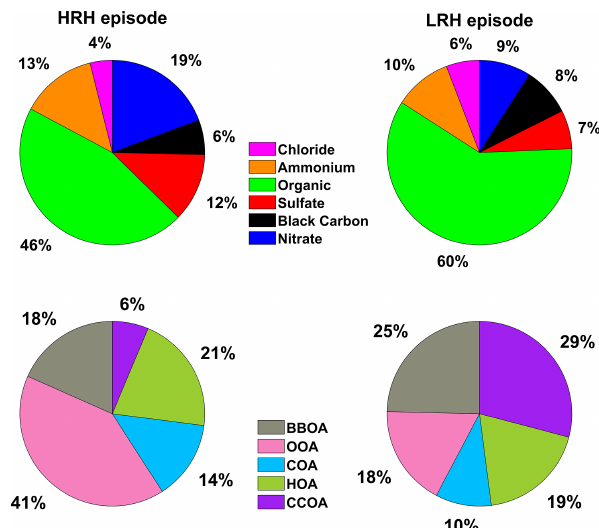
Figure 5. A comparison of the PM 1 chemical composition dur- ing the HRH and LRH episodes. (BBOA: biomass-burning organic aerosols, OOA: oxygenated organic aerosols, COA: cooking or- ganic aerosols, HOA: hydrocarbon organic aerosols, CCOA: coal combustion organic